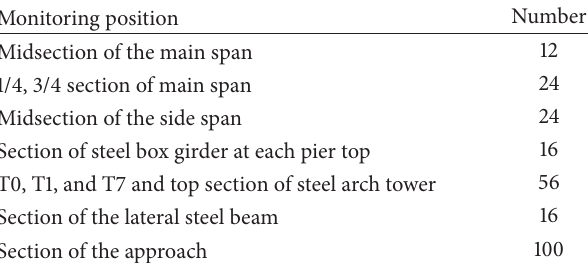
Table 6: Strain sensor arrangement.